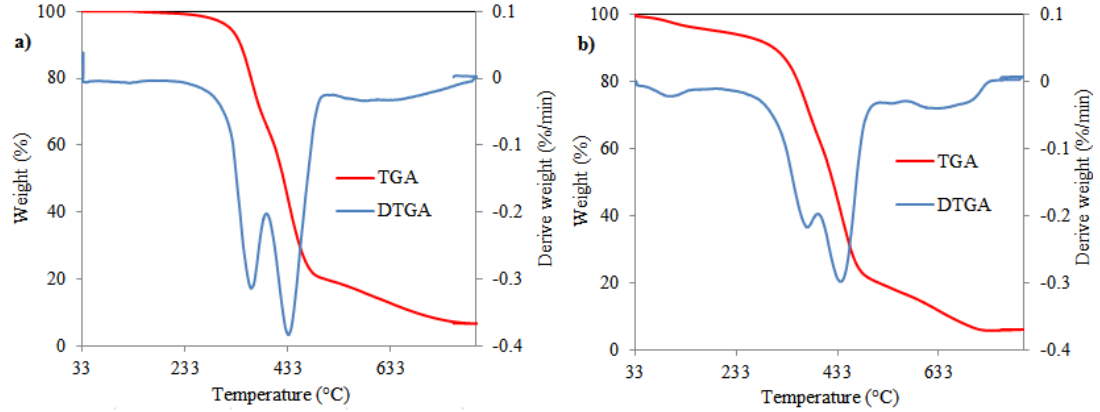
Figure 7. TGA curves for ( a ) cured neat epoxy resin (DGEBA) and ( b ) cured EUFAME/DGEBA blend. Table 5. Thermal degradation behaviors for cured neat epoxy resin (DGEBA) and cured EUFAME/DGEBA blend.